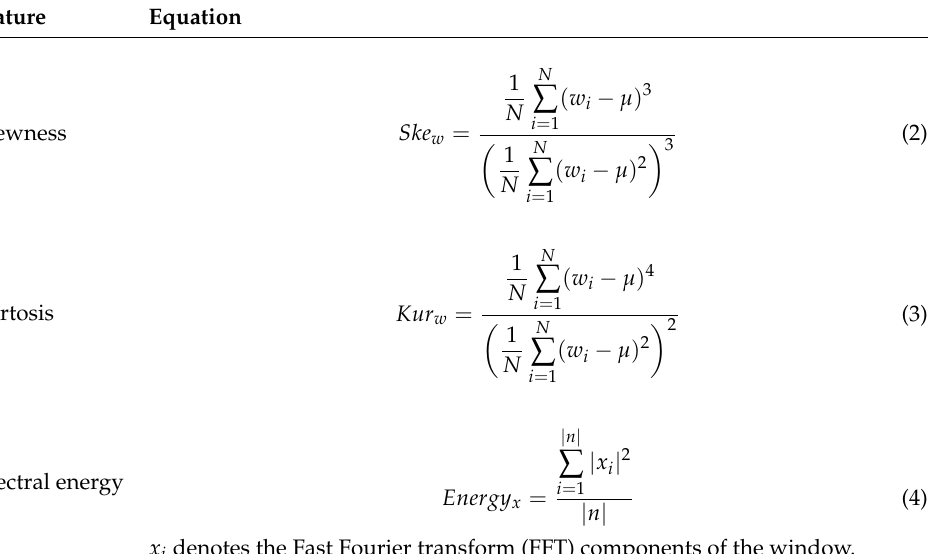
Table 5. Calculation of extracted